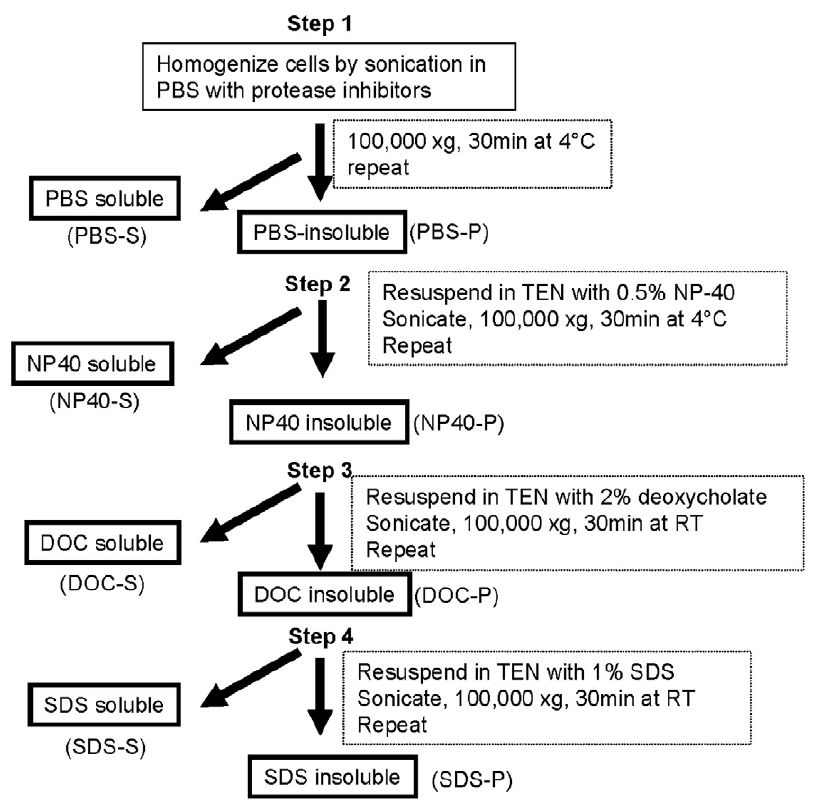
Figure 1. Diagram of detergent extraction and fractionation protocol.